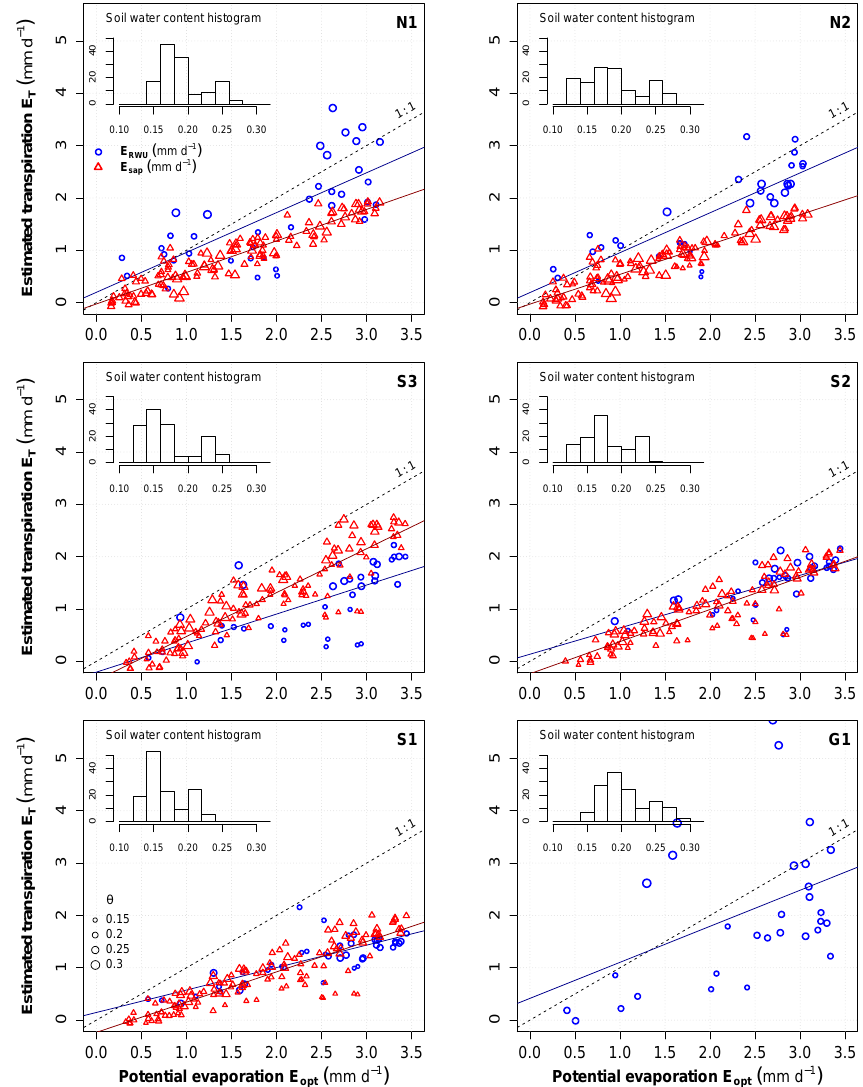
Figure 5. Site-average E RWU (blue circles) and E sap (red triangles) as function of E opt during vegetation period (10 June–20 October) in 2013. Each panel presents data of one site (see Figure 1 for site identifiers). The size of the symbols corresponds to the daily average soil moisture content. The histogram shows the distribution of site-average soil moisture. Solid lines depict the linear regression as tabulated in Table 2.